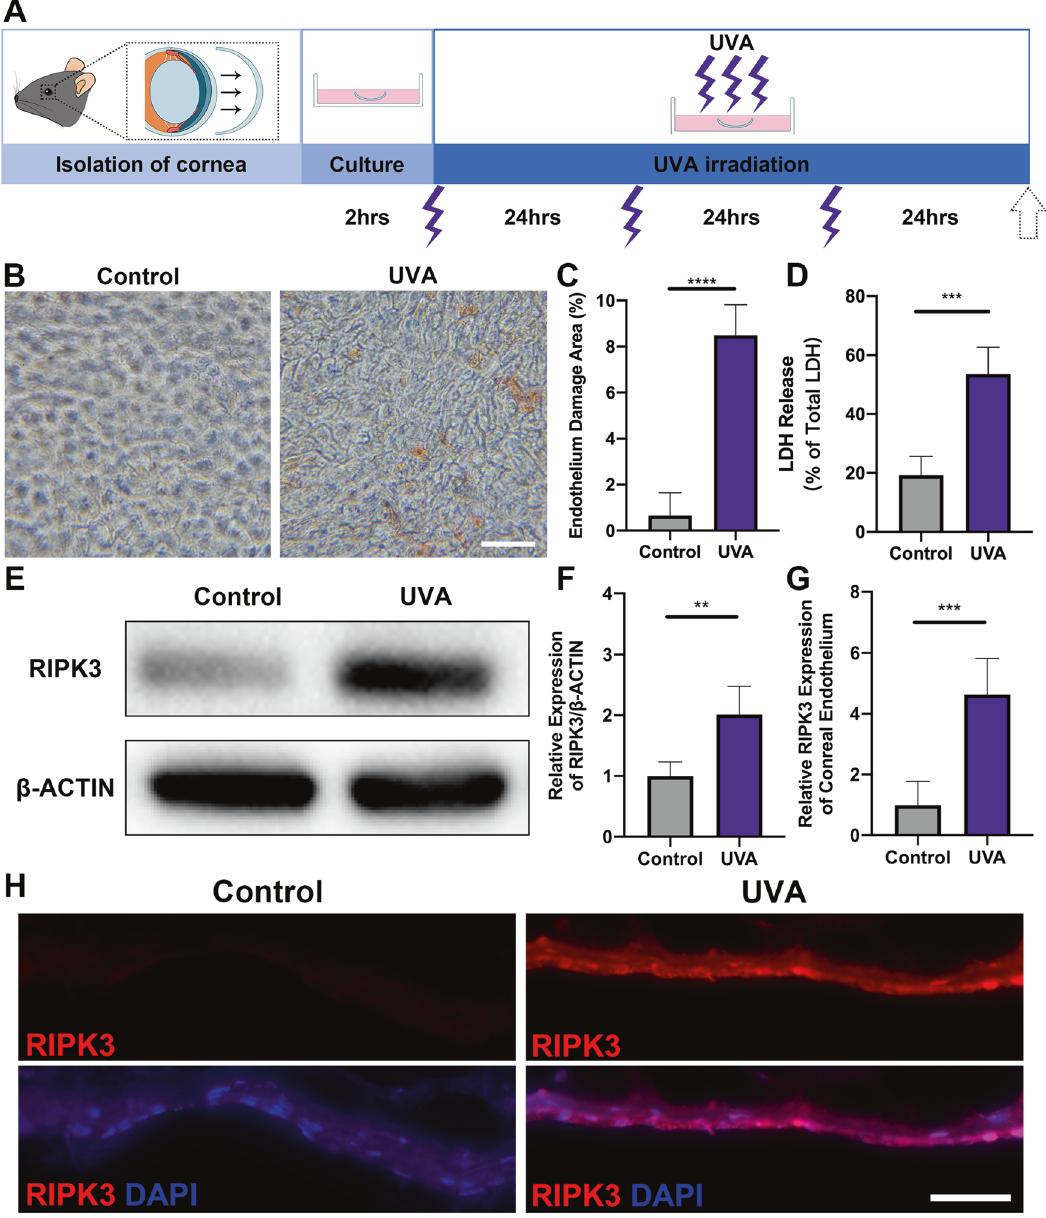
Fig. 1 High-dose UVA upregulates the RIPK3 expression in mouse CE. A Flow chart of cornea culture ex vivo and UVA irradiation model. The intensity and time of each UVA irradiation were 20 J/cm 2 (25 min 40 seconds every 24 h) for 72 h. B Representative images of Alizarin red S staining in mouse CE from the control and UVA groups (Scale Bar: 20 μ m). C Endothelium damage area (%) was analyzed by measuring the Alizarin red S-positive area ( n = 5 per group). D LDH release assays of mouse cornea after UVA irradiation ( n = 5 per group). E, F Western blot analysis of RIPK3 expression in mouse CE after UVA irradiation ( n = 4 per group). G, H Representative immuno fl uorescence images and analysis of RIPK3 (Red) and DAPI (Blue) localization in mouse CE with control and UVA irradiation. (Scale Bar: 50 μ m). The fl uorescence intensity of RIPK3 under UVA irradiation was compared based on the control group ( n = 5 per group). Statistical signi fi cance was analyzed with the unpaired Student ’ s t -test. **P < 0.01, ***P < 0.001, ****P < 0.0001 . All values are expressed as mean ±